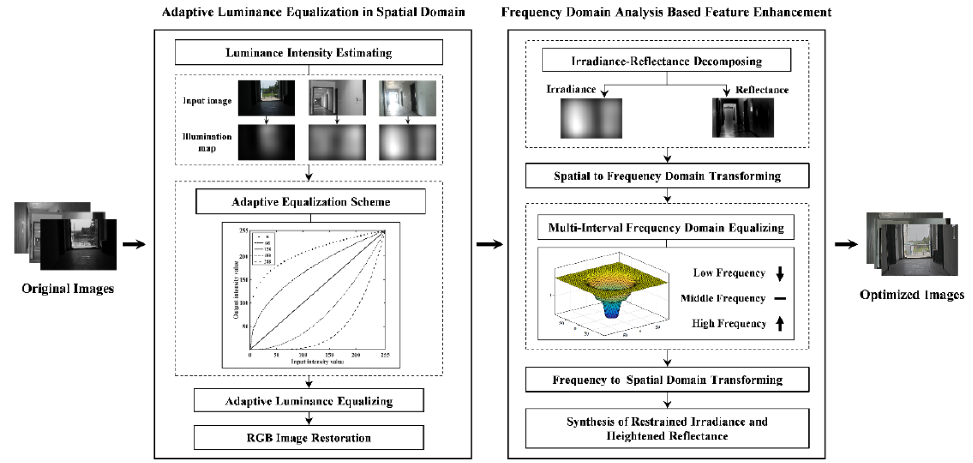
Figure 1. Flowchart of the proposed image-optimization method, including two steps, namely, adaptive luminance equalization and feature enhancement.